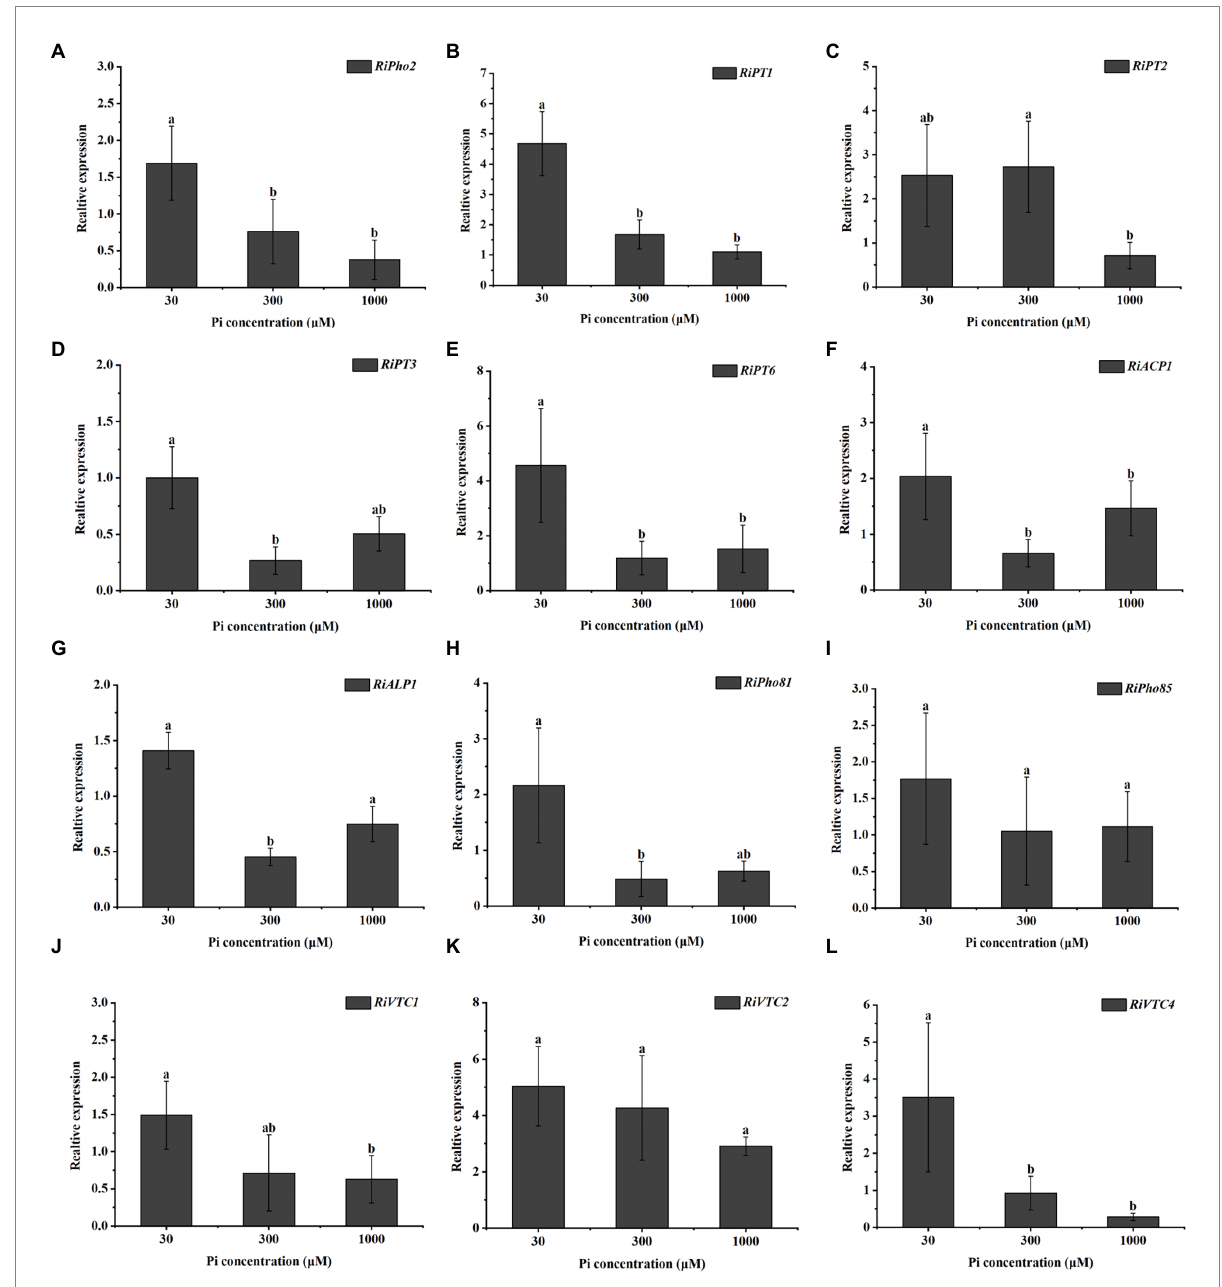
FIGURE 2 Expression profiles of the genes involved in the phosphate (PHO) signaling pathway from R. irregularis in mycorrhizal E. grandis roots at different phosphate concentrations. (A–L) Expression levels of genes of PHO pathway under different phosphate concentrations, including (A) transcription cofactor, (B–E) Pi transporters, (F,G) phosphatase related genes, (H,I) cyclin-protein genes and (J–L) vacuolar transporters, suggesting that the expressions of PHO pathway genes are affected by phosphate concentrations. AM fungal RiEF1 α is set as the reference gene. The data represent the means of three biological replicates with standard deviations. Different letters indicate the Duncan’s multiple comparison results. Significance, p <